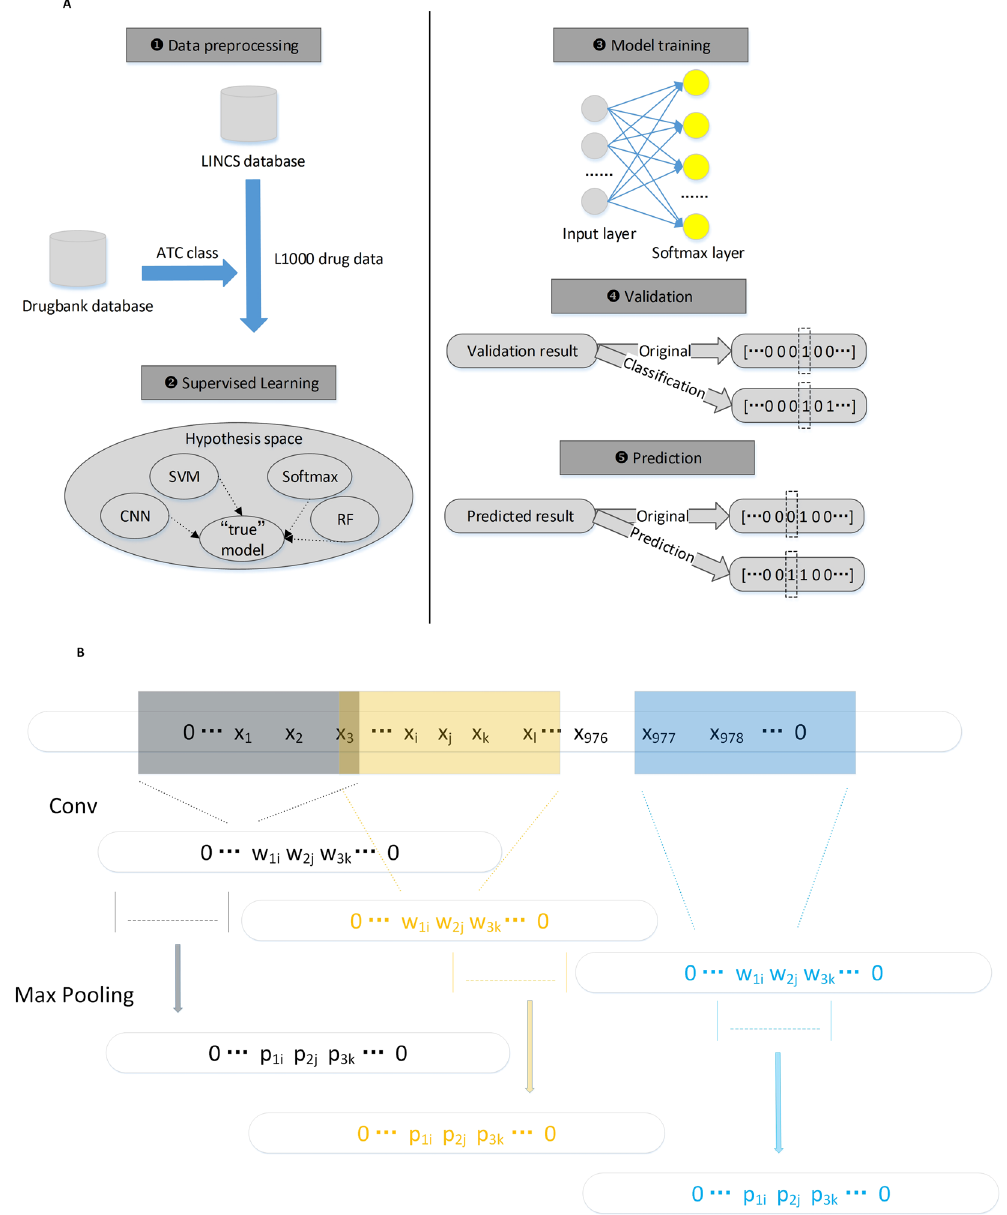
Figure 1. Total process and CNN architecture. ( A ) The whole process that contains data preprocess, supervised learning, model training, validation, and prediction. ( B ) The CNN architecture consists of two convolutional layers, two max pooling layers, one fully connected layer, and one classification layer. Different feature maps are extracted by various convolutional kernels based on sliding window and fed into max pooling layers for integrating local